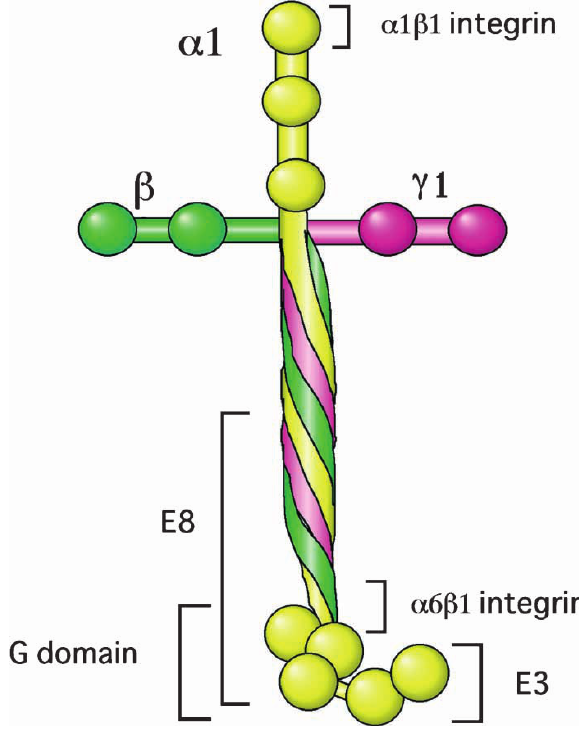
FIGURE 1 Structure of laminin-1. E3 and E8 designate proteolytic (elastase) fragments of laminin-1. Both a 1 b 1 and a 6 b 1 integrins indicate the integrin-binding sites of laminin- a 1